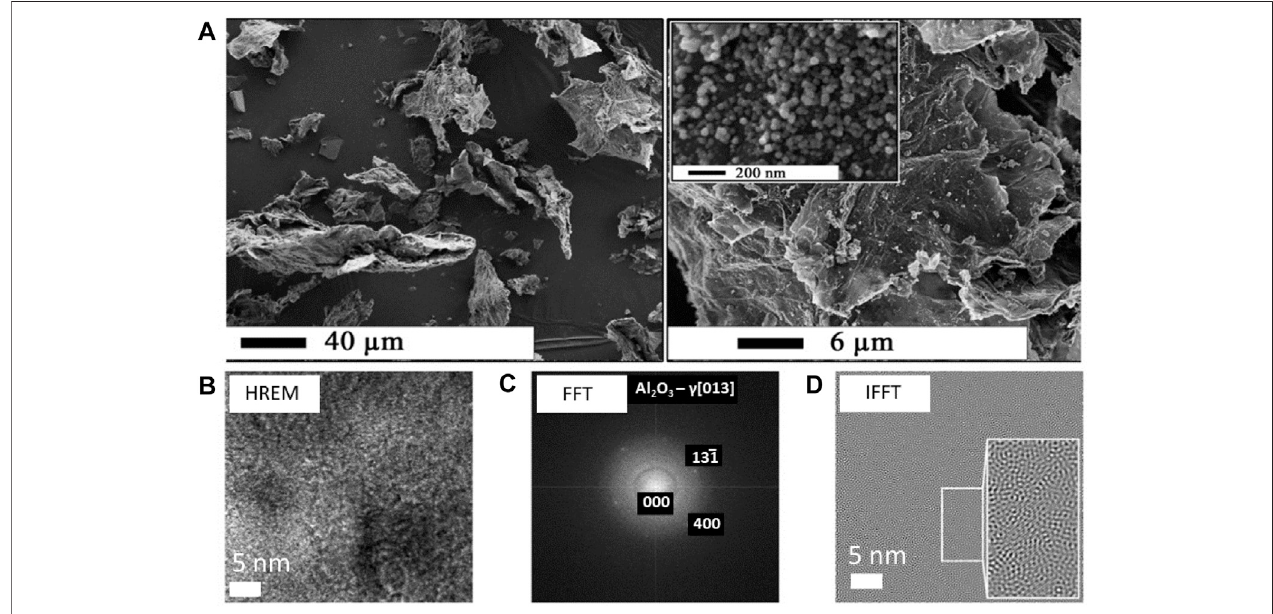
FIGURE 6 | SEM and TEM analysis of the RGO/Al 2 O 3 nanocomposite morphology (A) and structure (B – D) obtained via simpli fi ed sol-gel method (Reproduced with permission from (Jastrze ˛ bska et al., 2016a) with minor changes).